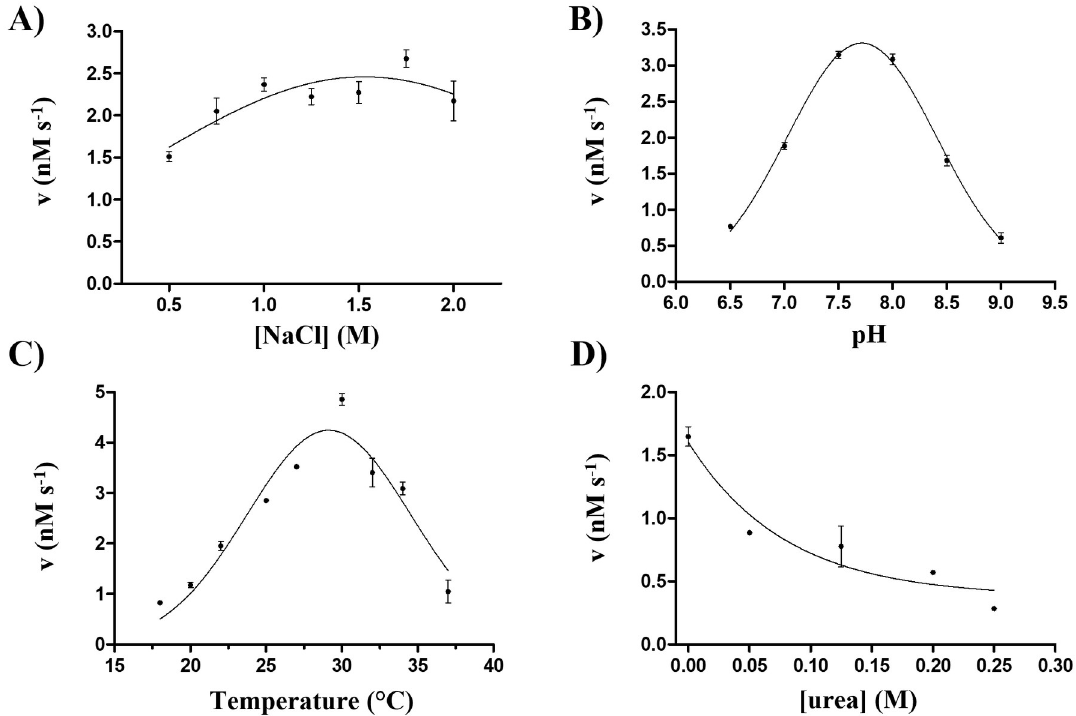
Fig 4. Effects of reaction conditions on Ty1 protease activity. In all measurements the enzyme was incubated with VPTIN � NVHTS synthetic substrate, and reaction velocity was determined (nM s -1 ). (A) Effects of ionic strength on the activity of Ty1 PR-His 6 measured at increasing NaCl concentrations. (B) Determination of the pH optimum of Ty1 PR-His 6 in 6.5–9.0 pH range. (C) Determination of the temperature optimum of Ty1 PR. D) Dependence of enzyme activity of Ty1 PR-His 6 on urea concentration (in 0–0.25 M concentration range). Error bars represent SD (n =